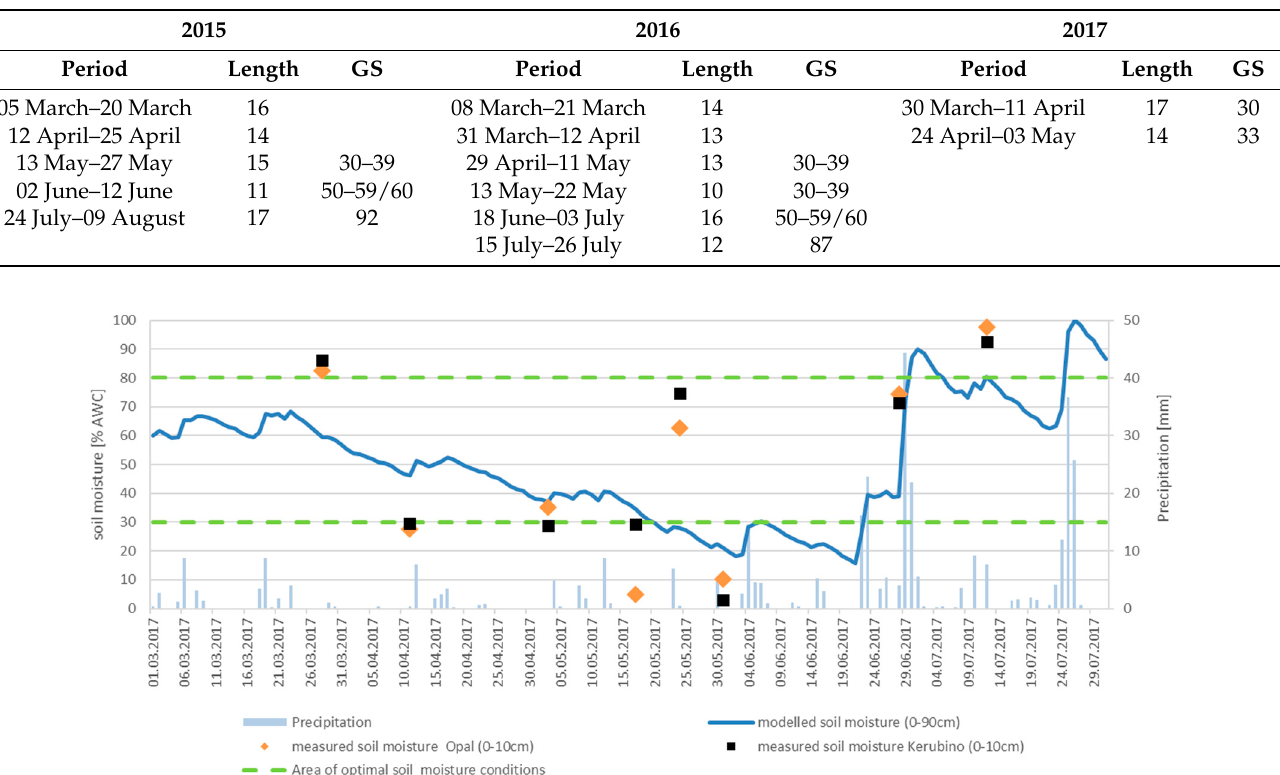
Figure 3. Modeled and measured soil moisture [% AWC] of unirrigated winter wheat plots Opal and Kerubino and precipitation [mm] in the period March to July 2017 .